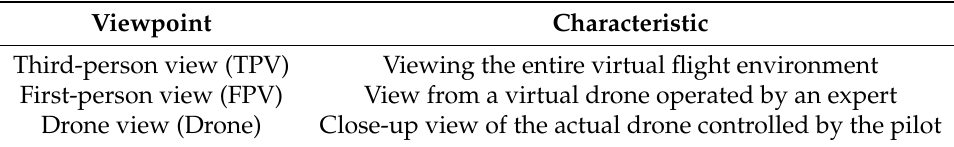
Table 1. Difference in viewpoints of a remote expert.